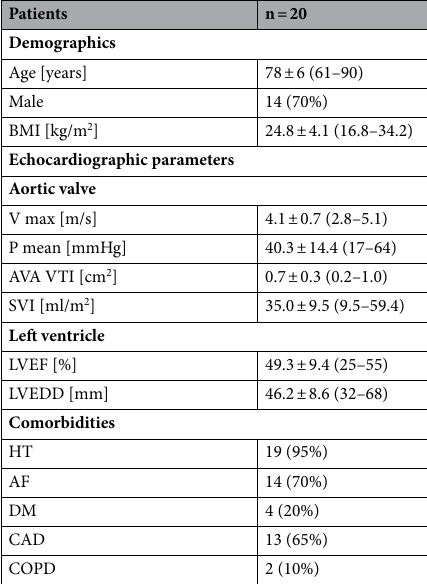
Table 4. Patients´ characteristics. BMI: Body-Mass-Index; V max: transvalvular peak velocity; P mean: transvalvular mean gradient; AVA VTI: aortic valve area measured by velocity time integral; SVI: stroke volume index; LVEF: left ventricular ejection fraction; LVEDD: left ventricular end diastolic diameter; HT: hypertension; AF: atrial fibrillation; DM: diabetes mellitus; CAD: coronary artery disease; COPD: chronic obstructive pulmonary